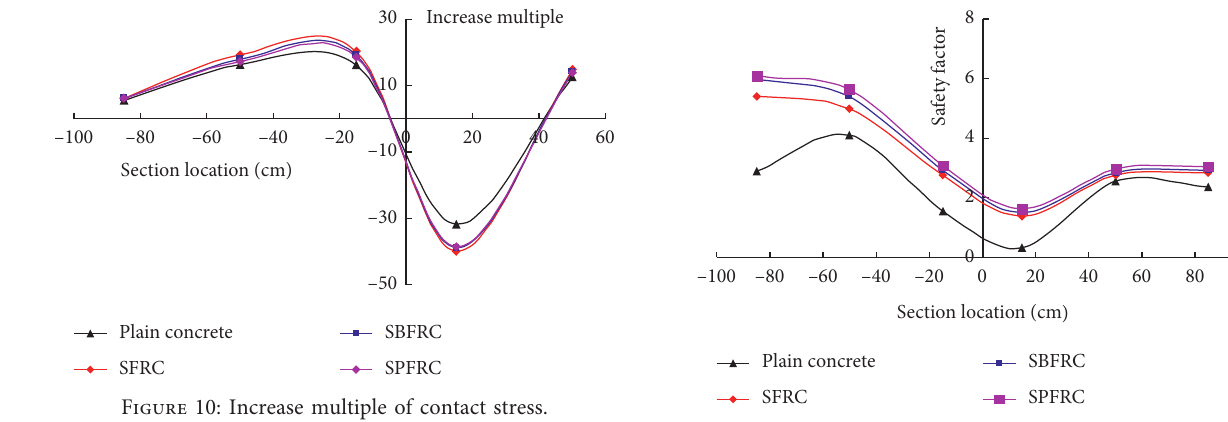
Figure 11: Safety factor. Table 11: Increase multiple of the minimum value of the safety —